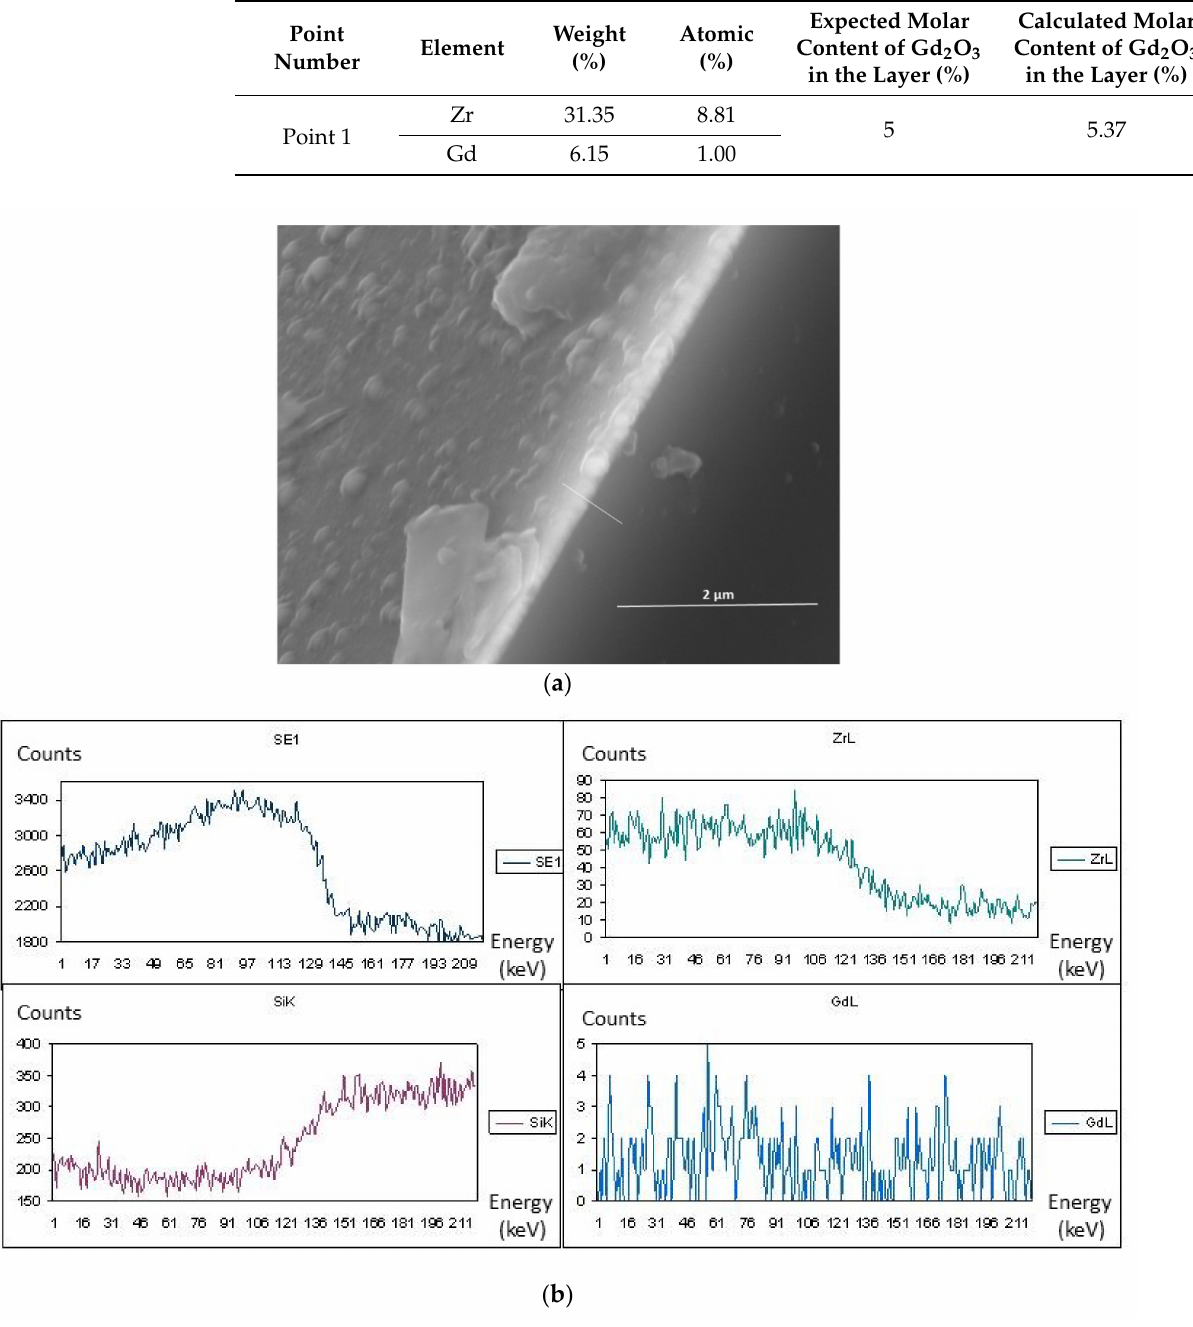
Figure 4. ZrO 2 -Gd 2 O 3 layer deposited at 600 ◦ C (its surface and cross-section) ( a ), with linear EDS analysis ( b ). Molar content of Gd(tmhd) 3 in the gas reaction mixture: 10%. Synthesis time: 30